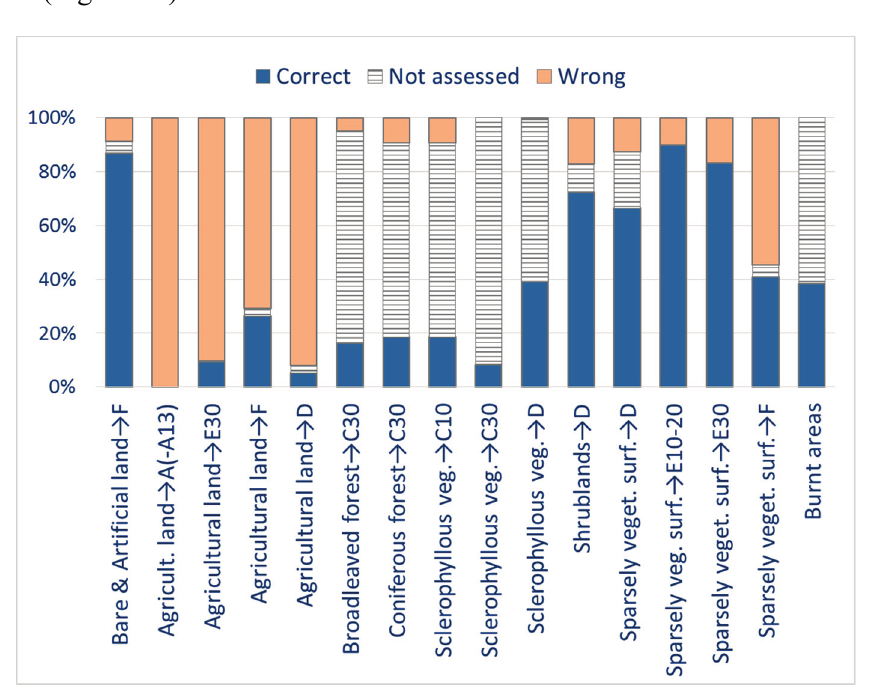
Figure 14. Distribution of correct, wrong, and not able to provide a clear assessment points per WWF Hellas category, as resulted from the supervised validation